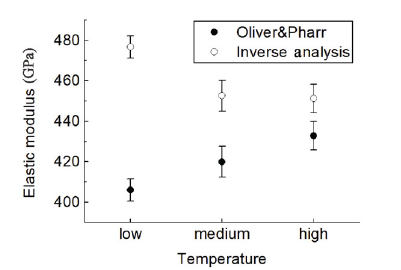
Fig. 13 Measured force displacement curves (dotted lines) and best fit result from the FEM model for the measurement of coatings with different thicknesses and deposition temperatures.